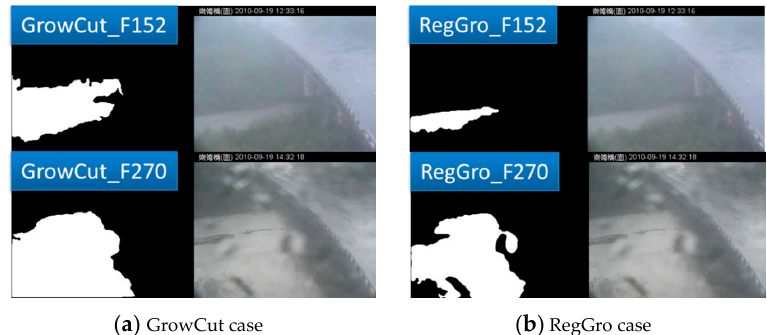
Figure 18. Comparison of the two algorithms with example images from the start (Image 152) and middle (Image 270). ( a ) GrowCut covering the stains (Image 152) and overestimating them (Image 270); ( b ) RegGro identifying the flood region (Image 152) and affected by stains (Image 270). (Note: The Traditional Chinese in header of all images is represented the location in the Changed Bridge). except).